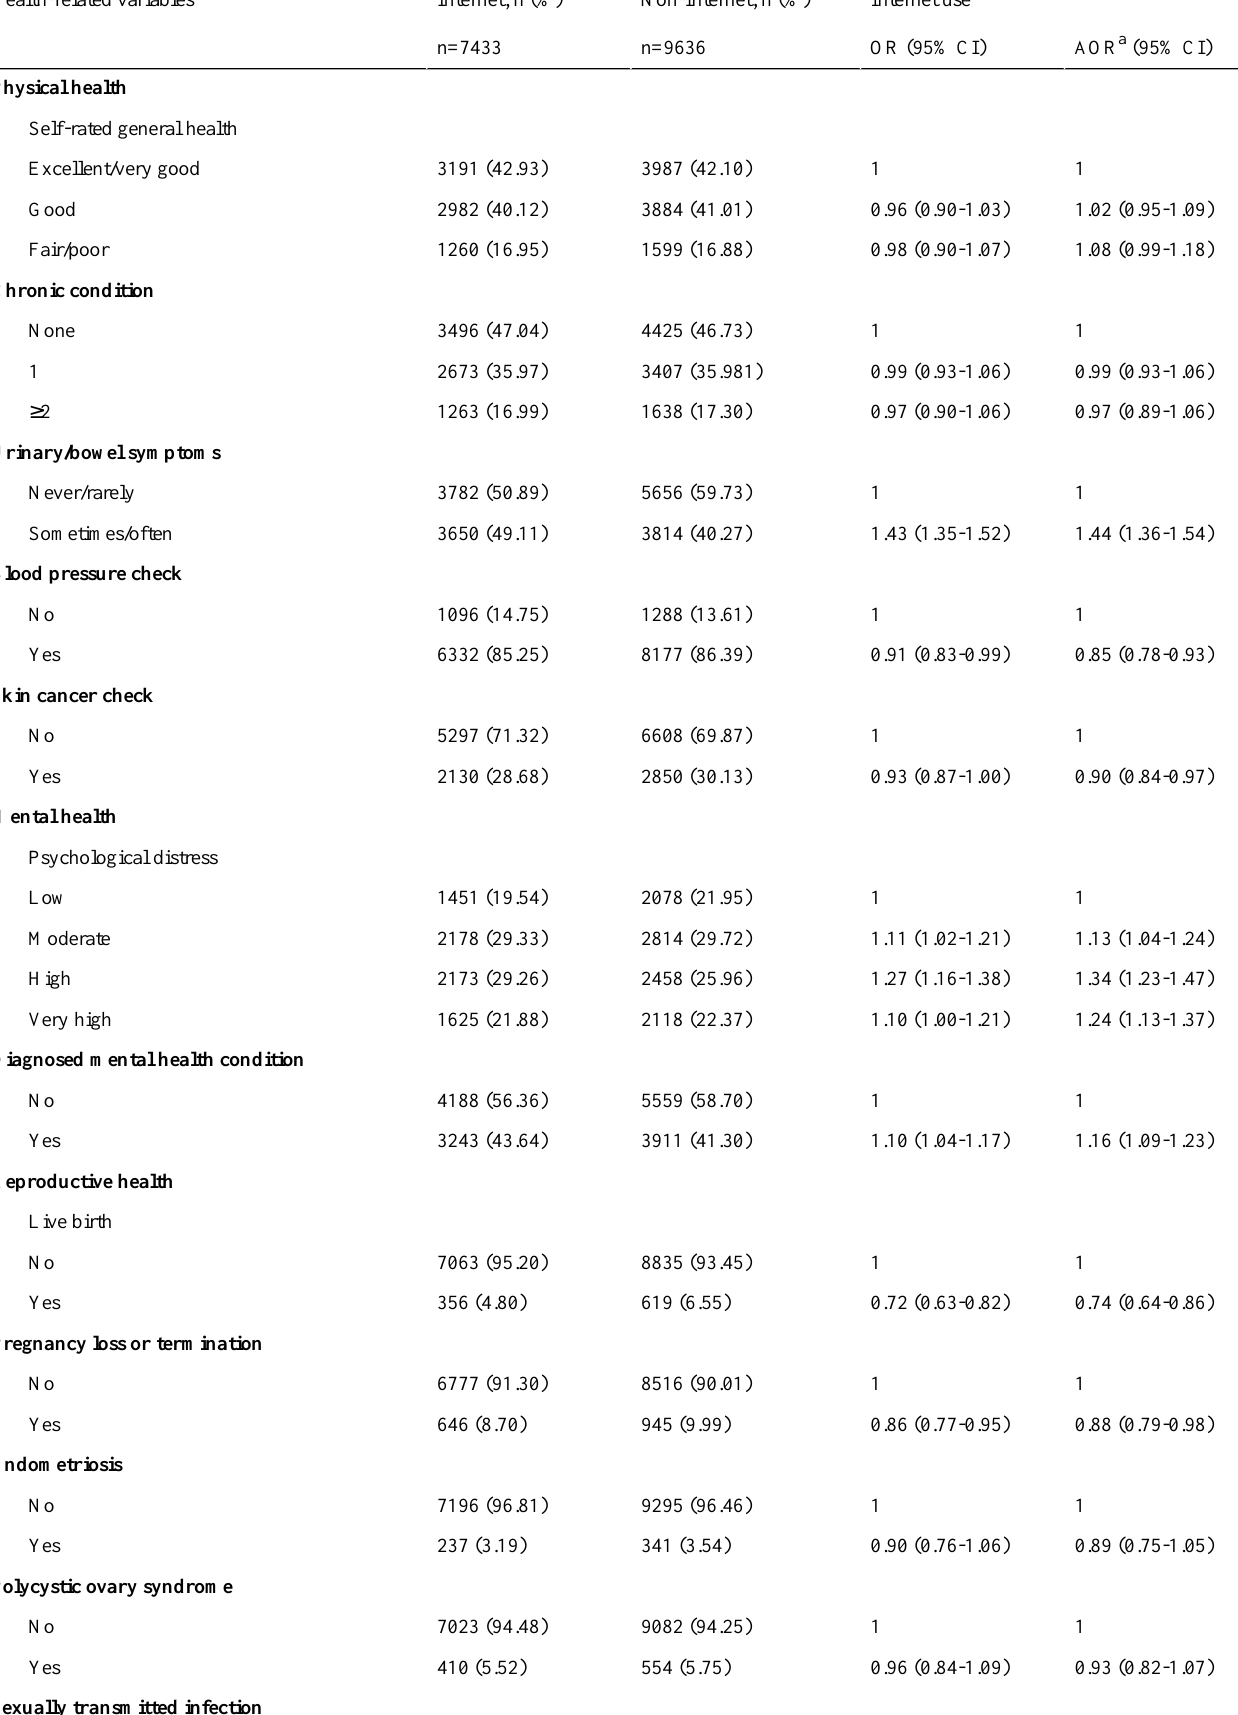
Internet useNon-Internet, n (%)Internet, n (%)Health-related